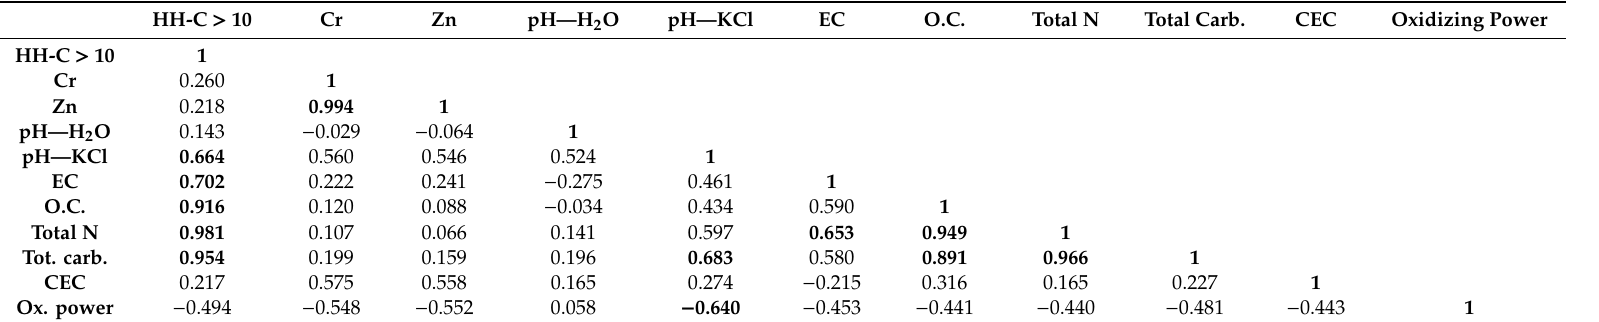
Table 3. Pearson correlation coe ffi cients between the main soil contaminants and the soil